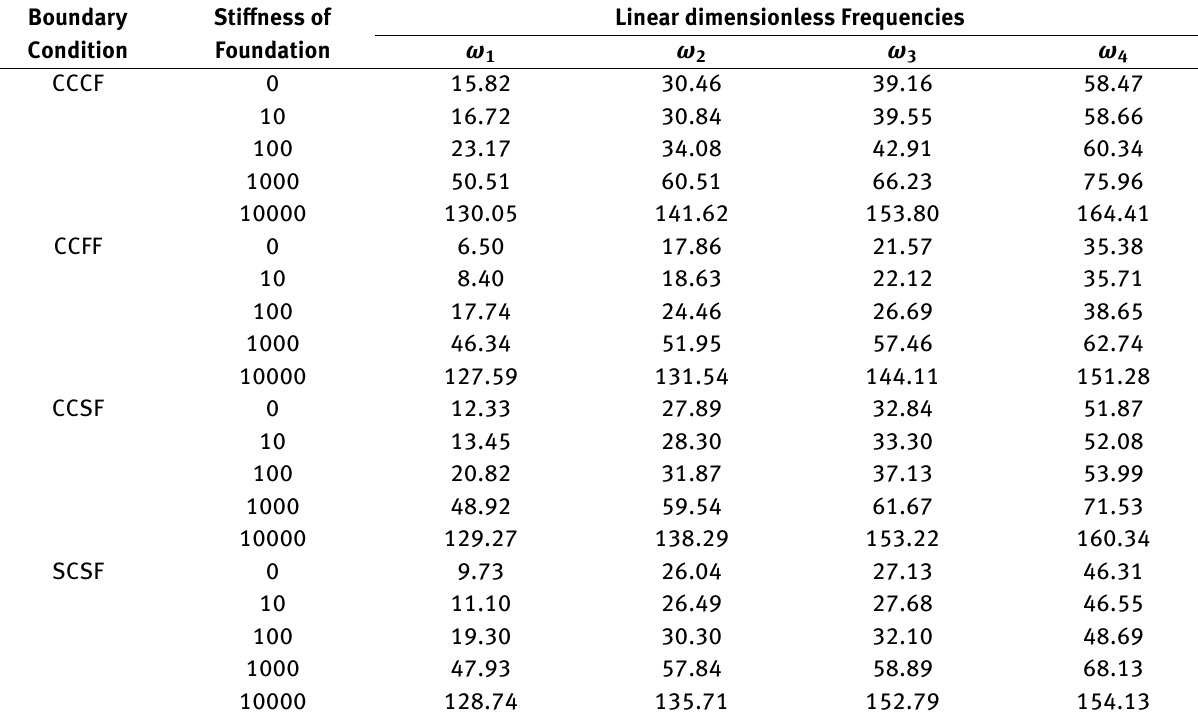
(︁ )︁ for different Boundary Conditions Ωa 2 / √︀ ρ 0 t 0 / D